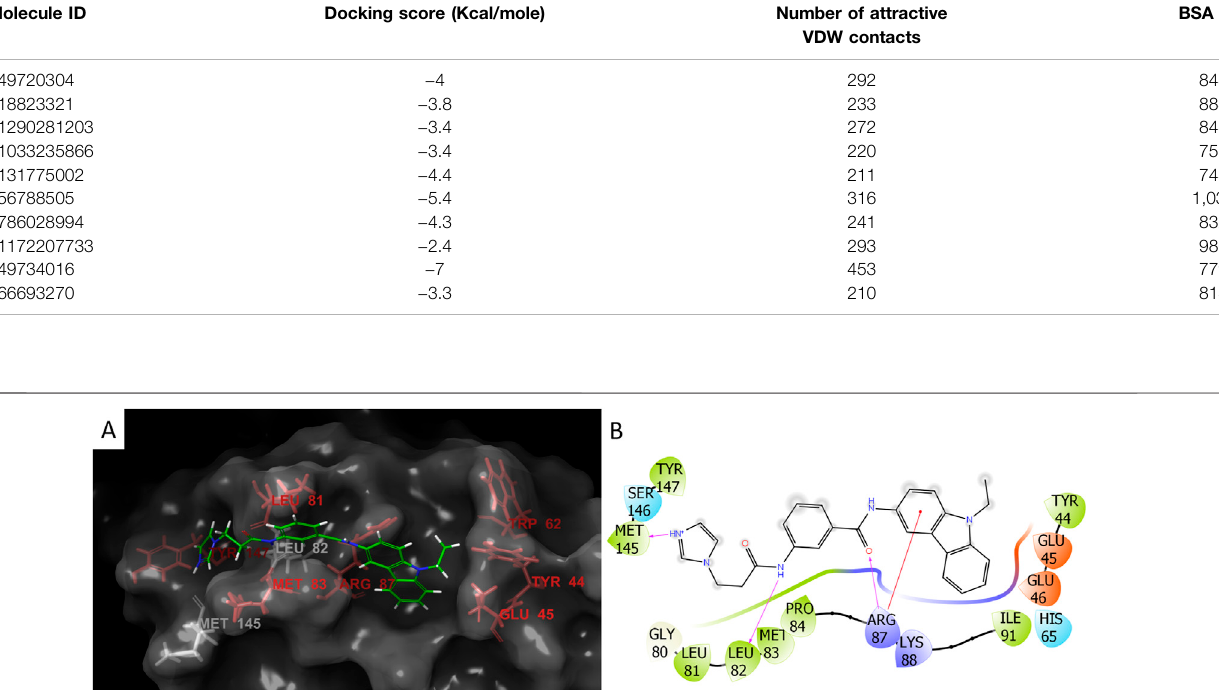
TABLE 2 | Top scored molecules sent for the in vitro test. Molecule ID Docking score (Kcal/mole)